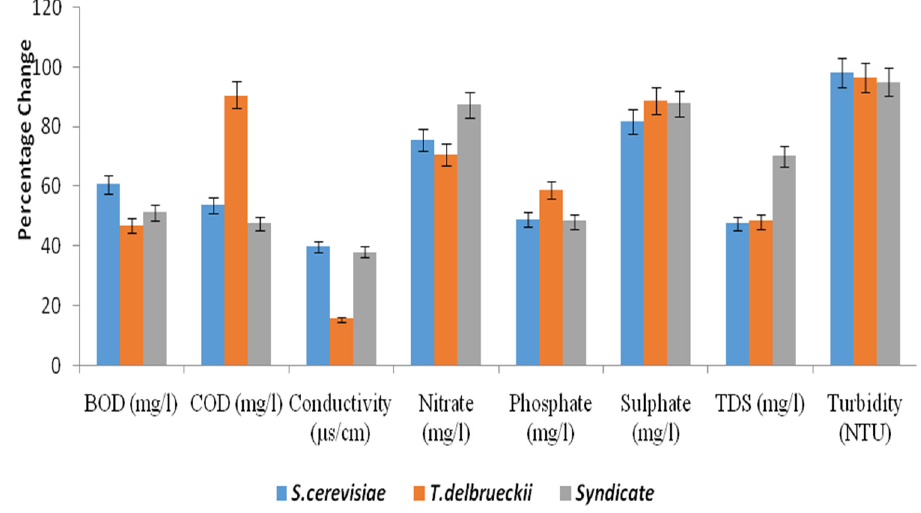
Figure 3. Percentage change in physicochemical parameters after treatment of 100% tannery effluent with yeast species and syndicate.